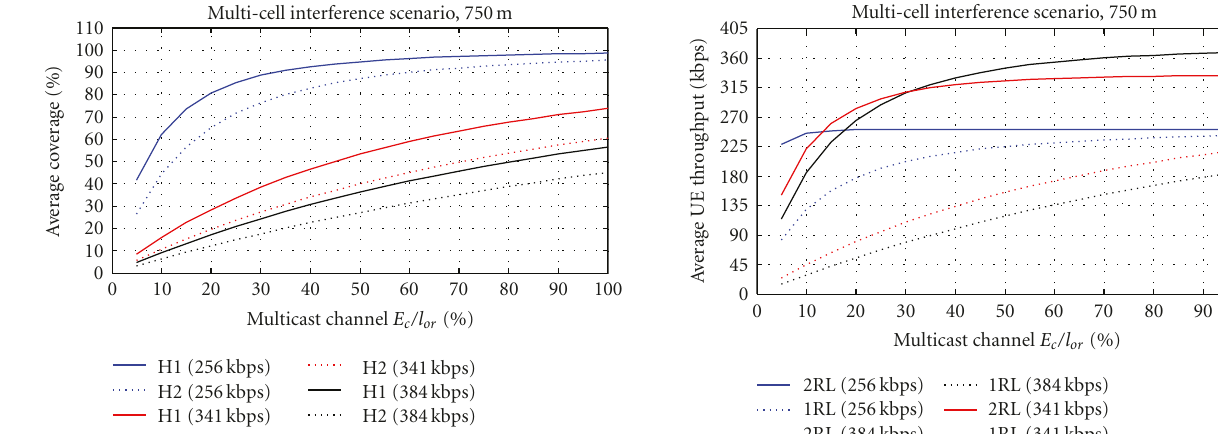
Figure 12: Throughput versus E c /I or , R = 750 m, k = 0 . 5.